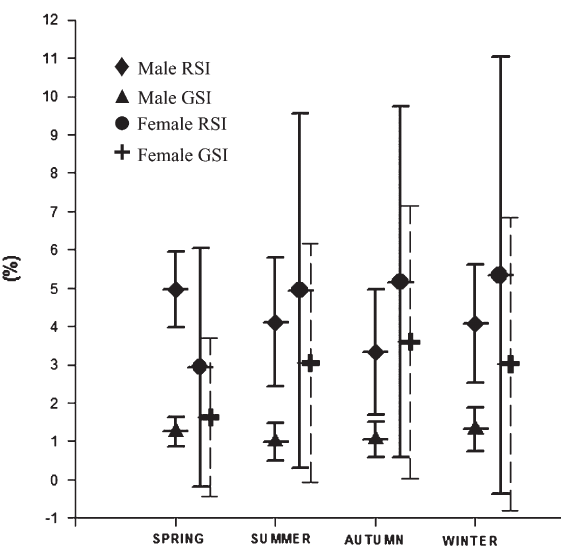
Fig. 4. – Seasonal variation of the Gonadosomatic index for male and female N. caroli from the Aegean Sea; bars ± standard deviations.